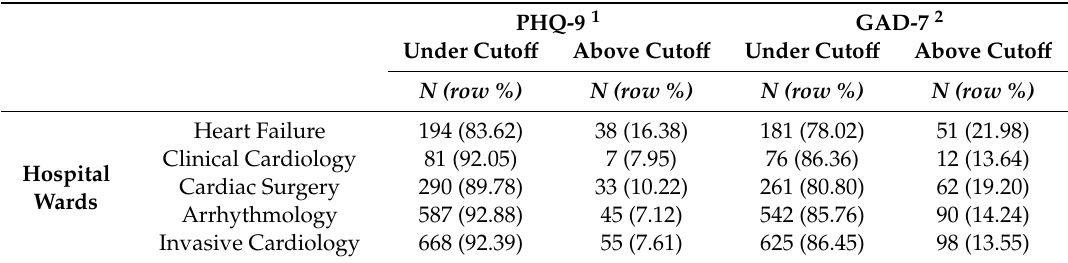
Table 4. Depressive and anxiety symptoms in the di ff erent hospital wards.